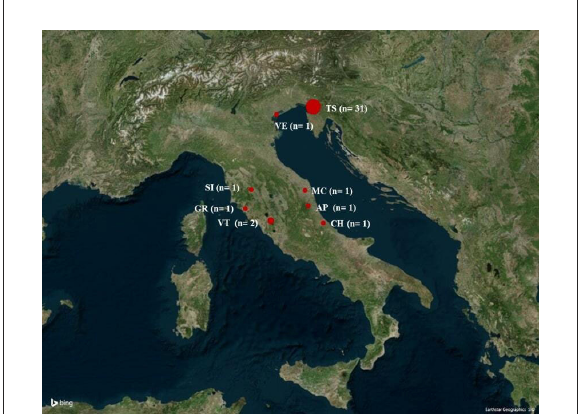
FIGURE2 Map of Italy showing the cities where Cytauxzoon spp. infected cats were diagnosed. The map was obtained by Microsoft 3D Maps in Excel 2016 software. AP, Ascoli Piceno; CH, Chieti; GR, Grosseto; MC, Macerata; SI, Siena; TS, Trieste; VE, Venezia; VT,